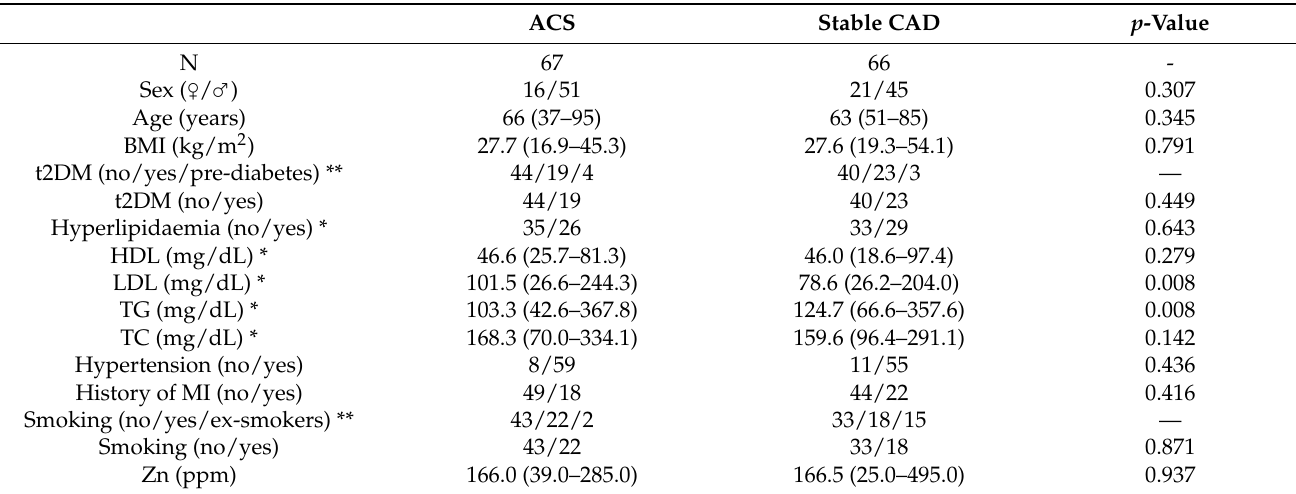
3.3. Difference in Zn Level between Patients with Stable CAD and Patients with ACS Significant differences were observed between patients with ACS and stable CAD in LDL and triglyceride (TG) levels (Table 2). Table 2. Differences in selected parameters between patients with ACS and stable